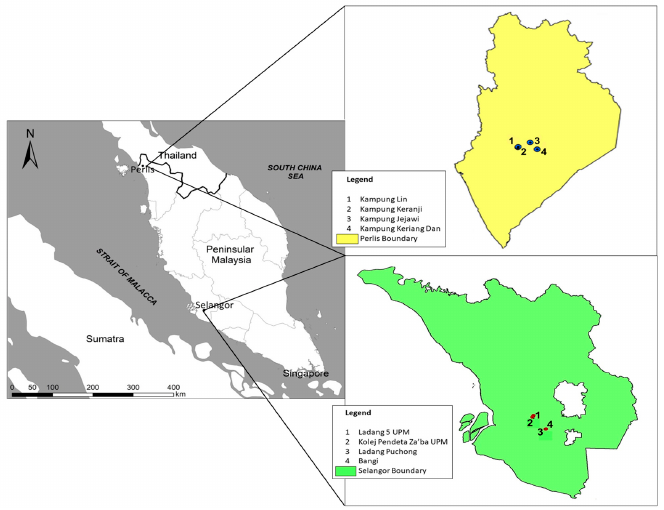
Figure 1. The location of the baya weaver ( Ploceus philippinus ) nest locations at the Selangor and Perlis sites.